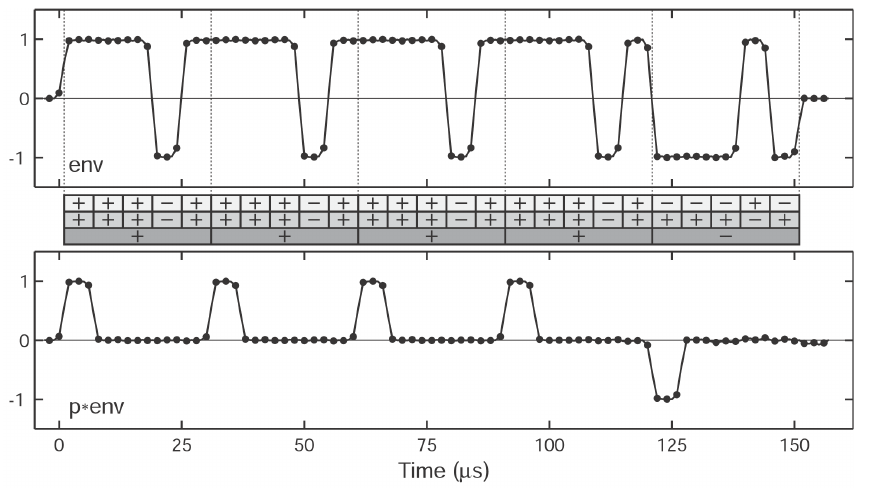
Fig. 2. The modulation envelope (env) of the Barker coded 5-bit code transmission and the decoded signal (p ∗ env ) . The bottom line of the sign pattern indicates the phases of the basic 5-bit modulation, the middle line the phases of the 5-bit Barker code and the top line the product of these two sign sequences, indicating the phase behaviour of the modulation envelope. The vertical dashed lines show the boundaries of the bits of the basic